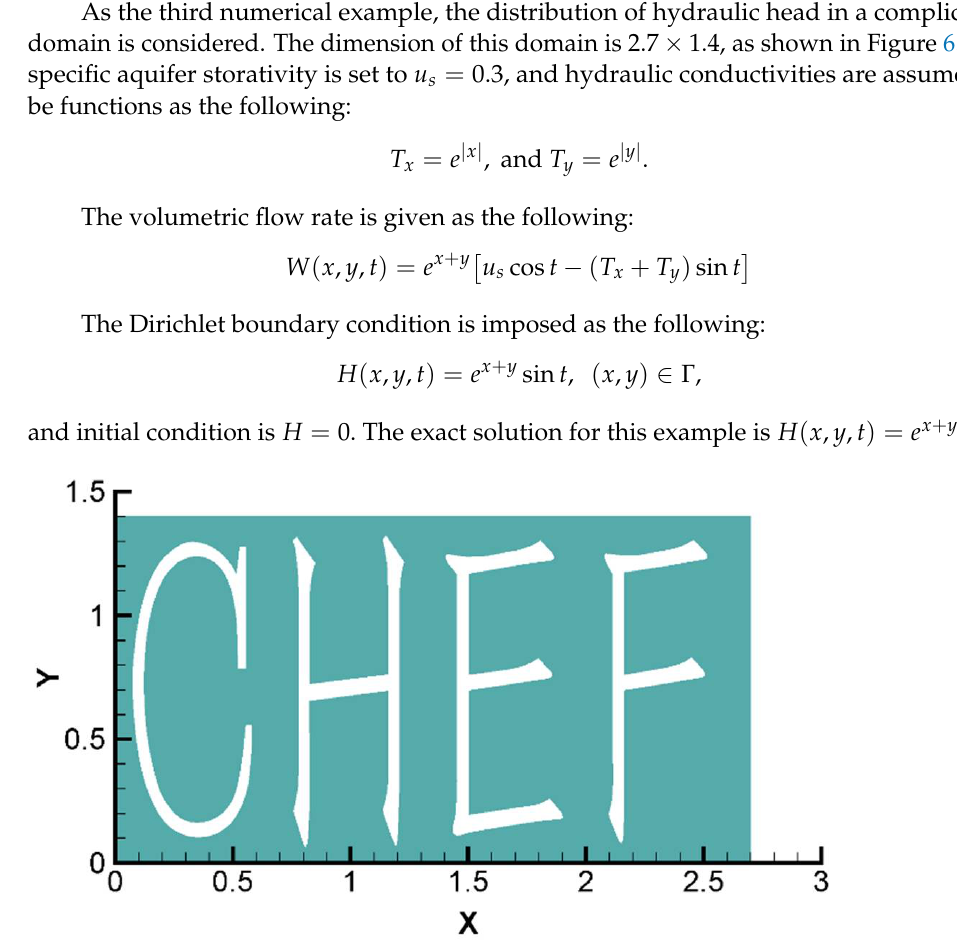
Figure 6. The dimension of a complicated domain.